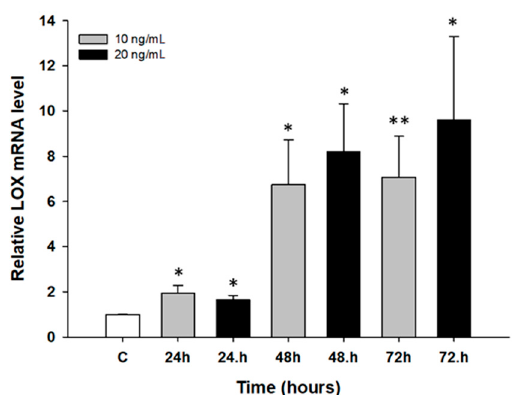
Figure 2. Expression analysis of the LOX gene in the W1 cell line after short time exposure to PAC. The figure presents relative genes expression in PAC treated cells (gray and black bars) with respect to the untreated control (white bars) assigned as 1. The values were considered significant at * p < 0.05 and ** p < 0.01.